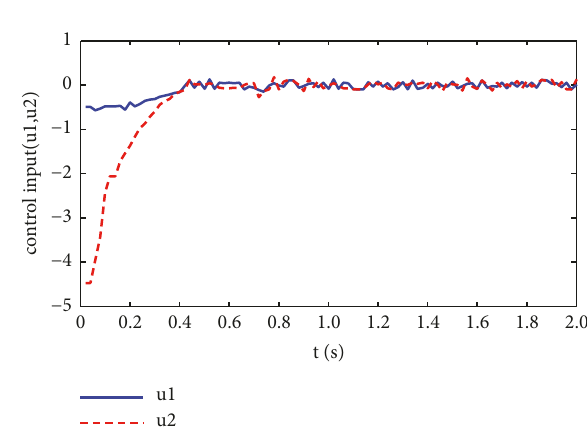
Figure 7: Control input trajectory with the classic reaching law based SMC.